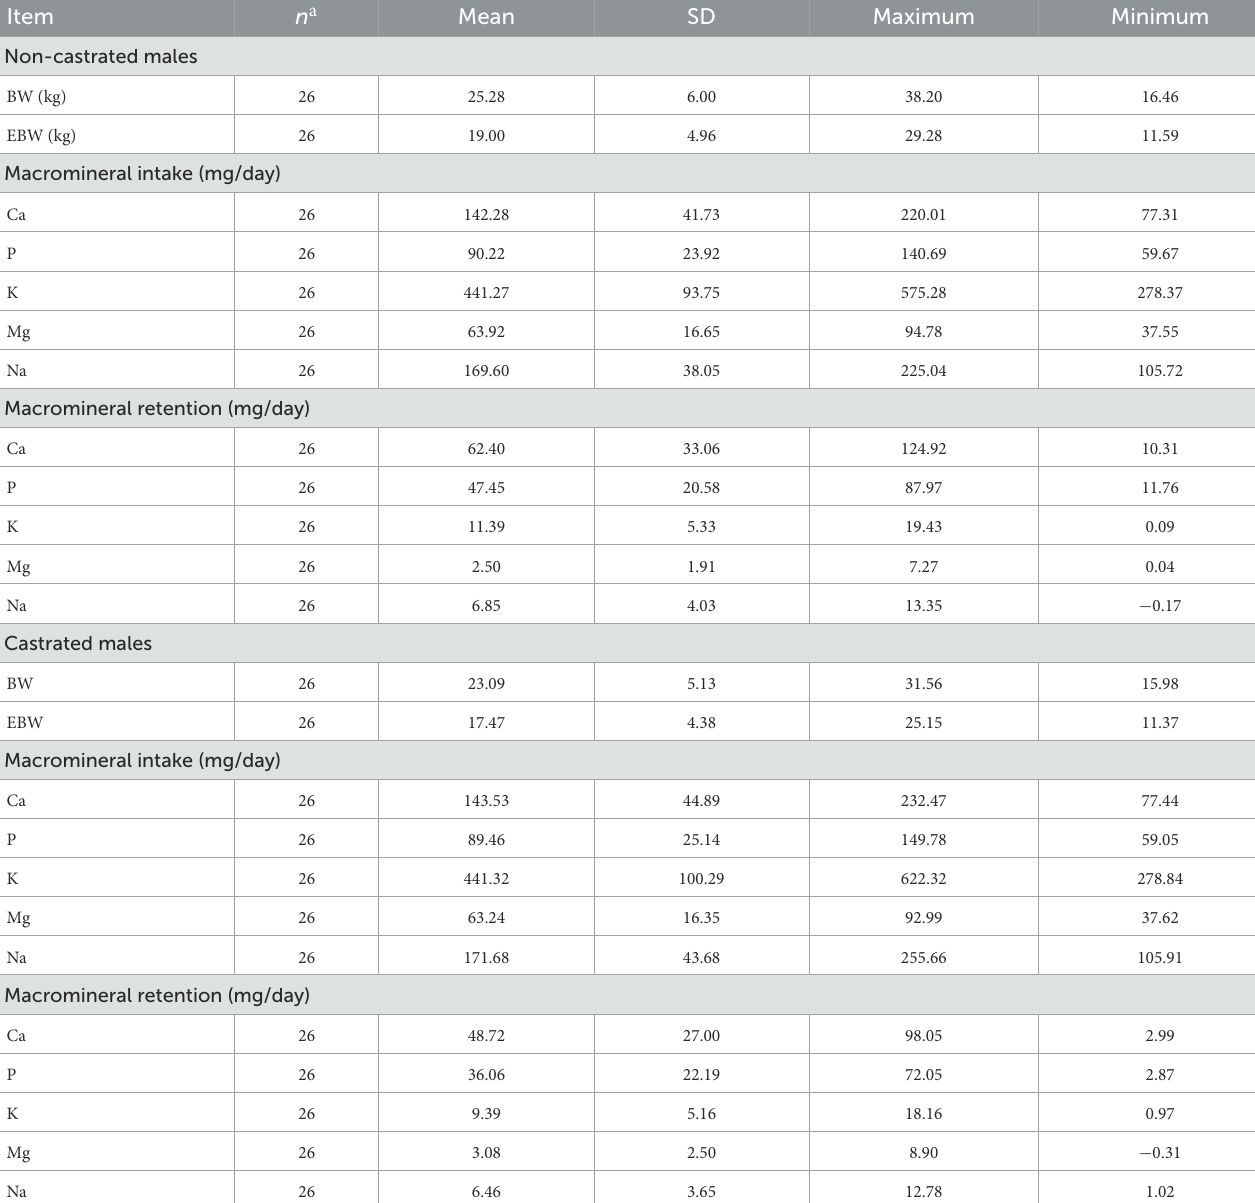
TABLE 3 Descriptive statistics of the data used to estimate the net requirements of macrominerals for maintenance in hair sheep. Item n a Mean SD Maximum